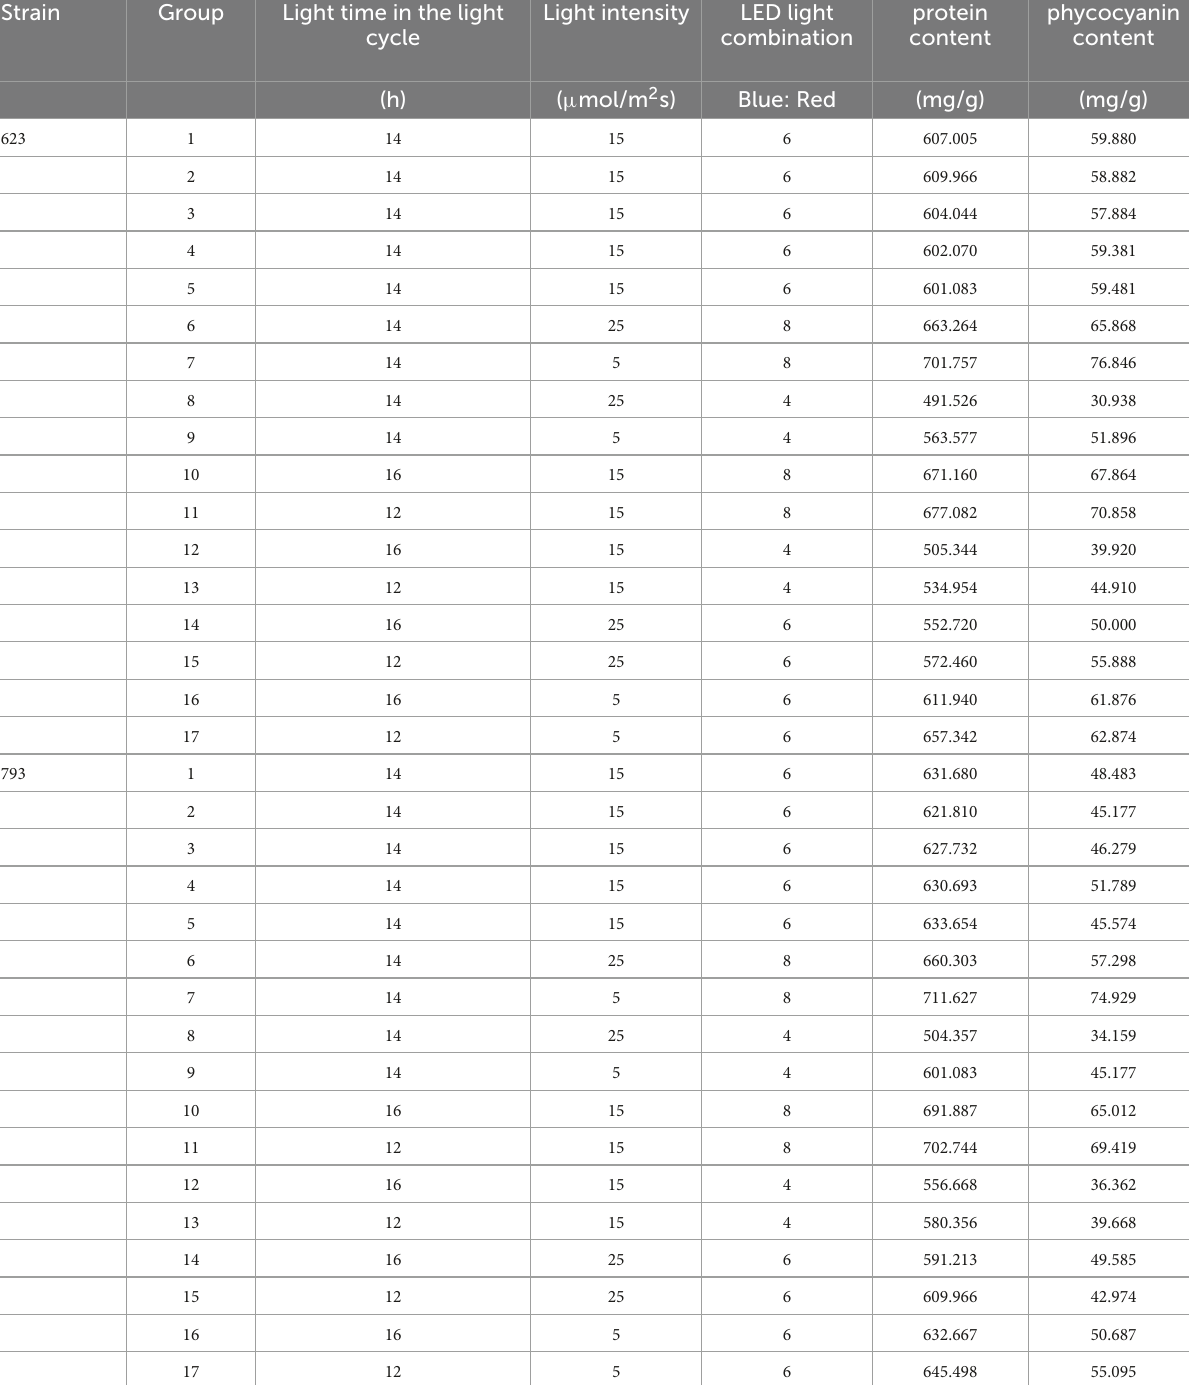
TABLE 7 Response surface experimental design and results of protein and phycocyanin accumulation of Arthrospira platensis OUC623 and A. platensis OUC793. Strain Group Light time in the light